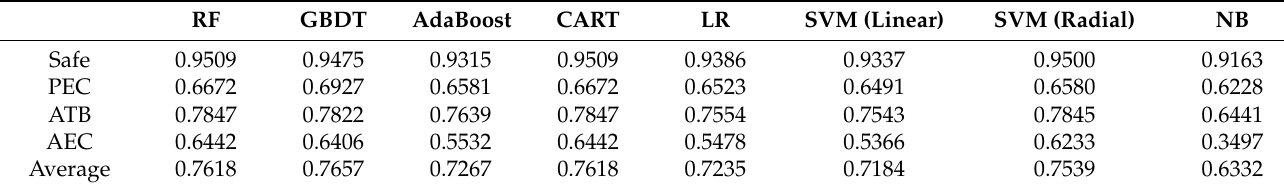
Table 4. F1-score after feature interaction.